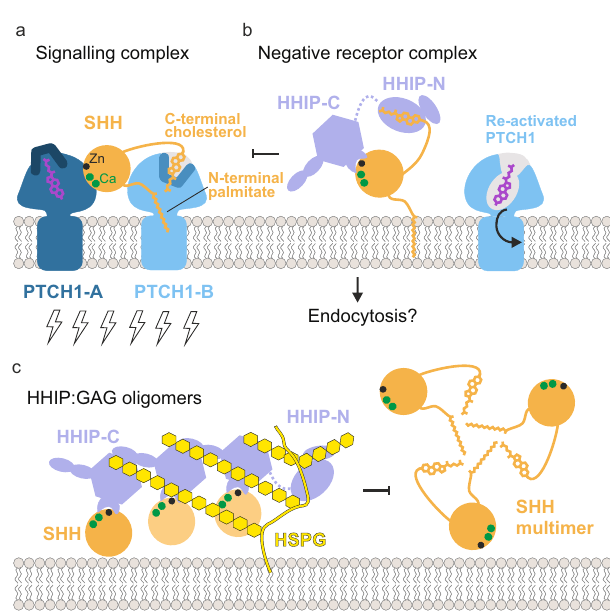
Fig. 6 Models of extracellular HH signalling antagonism by HHIP. a A 2:1 interaction of PTCH1:pShhNc represents the active signalling complex. The pShhNc lipid appendages insert to seal channels in PTCH1-B. b HHIP-C targets the conserved high-af fi nity metal ion-binding site on the pShhNc surface ( ‘ protein-protein interaction ’ ), competing with binding from PTCH1- A and other co-receptors, whilst HHIP-N is able to contribute to this by targeting the C-terminal cholesterol moiety, possibly re-establishing PTCH1 cholesterol transport ability. It is also of note that HH signalling is activated via SMO CRD-cholesterol interaction, and competition of this by the HHIP- N CRD represents a possible additional mode of inhibition. Additionally, HHIP-mediated receptor endocytosis may act to remove SHH from the cell surface. c Cell surface GAG-mediated clustering represents a second modality for HH regulation by HHIP. The avidity of HHIP is increased by cluster formation at the proteoglycan layer, similar to how SHH lipoprotein multimers act to increase local morphogen concentration. The GAG- binding site in HHIP-N is also important for this